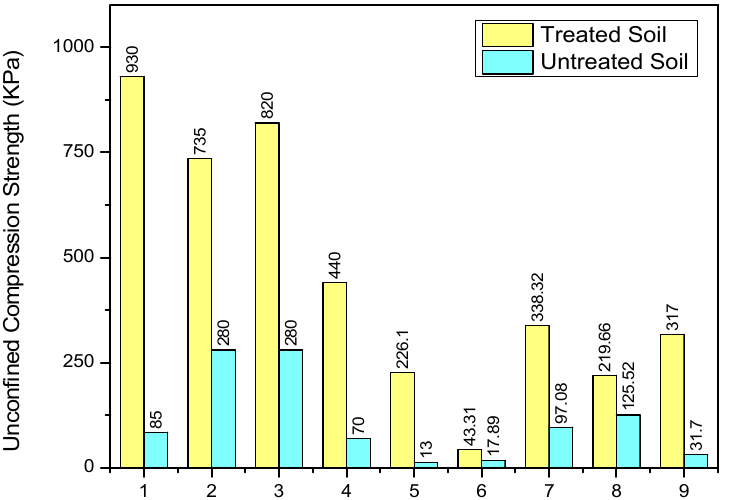
Figure 2. Comparison of unconfined compressive strength (UCS) results for soil samples before and after biotreatment. 1—Sotoudehfar et al. [85], 2—Wani and Mir [93], 3—Wani and Mir [93], 4—Moghal et al. [94], 5—Moghal et al. [94], 6—Xiao et al. [95], 7—Sharma and R [92], 8—Sharma